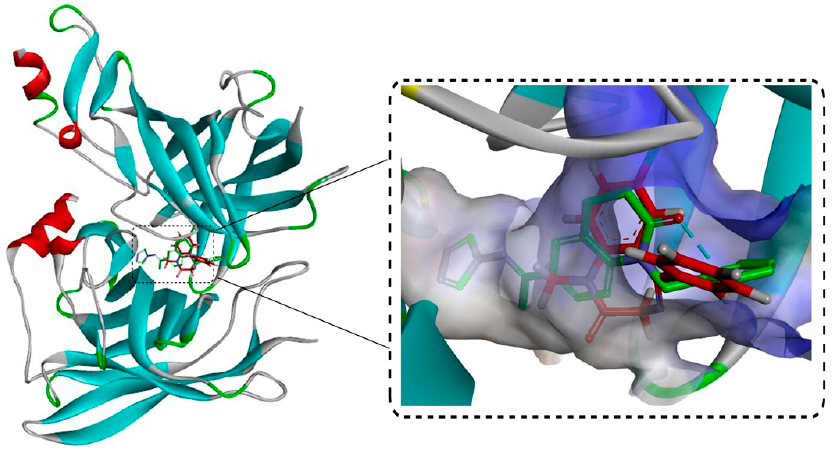
Figure 9. The overlying pattern of compound 3g (green), and diazepam (red) in the binding pocket of the GABA A receptor.